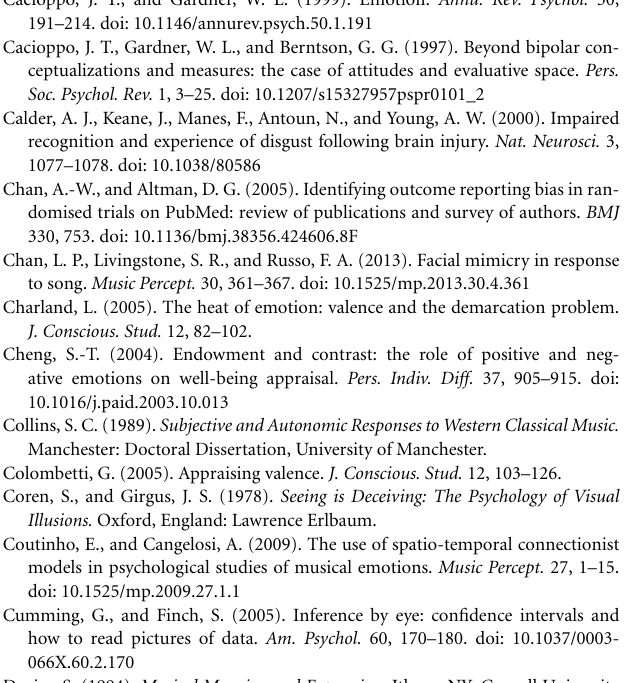
Supplementary Table 1 | Summary of emotion locus in music studies